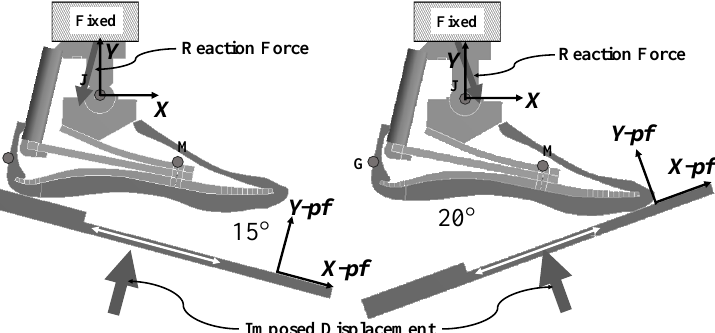
Figure 4. Schematic image of the boundary conditions used for the 2D FE model of the Design step, which was used to simulate the static tests according to ISO 10328. The heel was loaded with an inclined platform ( − 15°) to which a displacement was imposed (10 mm); the forefoot was compressed with a 20° inclined platform which was moved until 50 mm. In both cases, the platform was free to move along its longitudinal